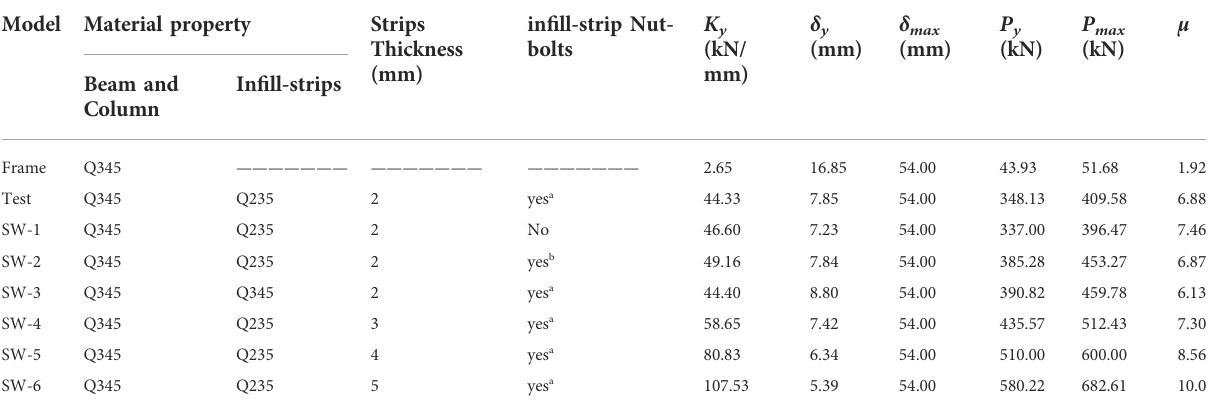
TABLE 6 The models ’ parametric analysis and the results of those investigations. Model Material